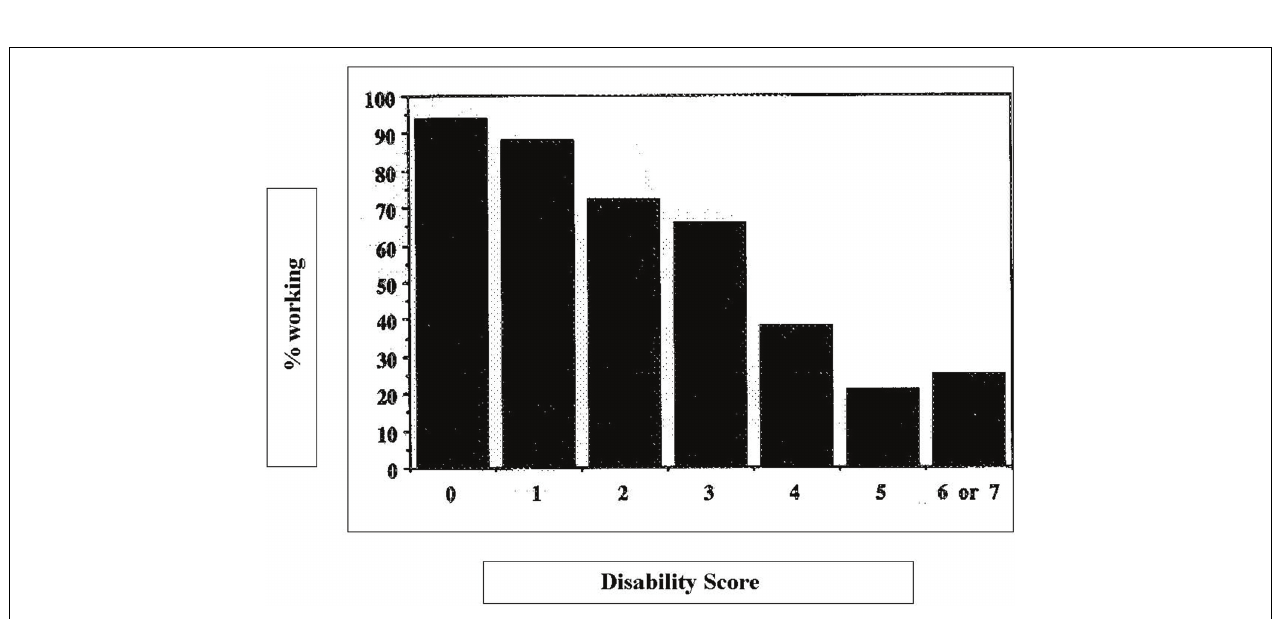
and met66 BDNF alleles in healthy subjects and patients with neurological or psychiatric disorders (Krueger et al., 2011). PH3 reported a functional relationship between the BDNF val66met genotype and recovery of executive function in subjects